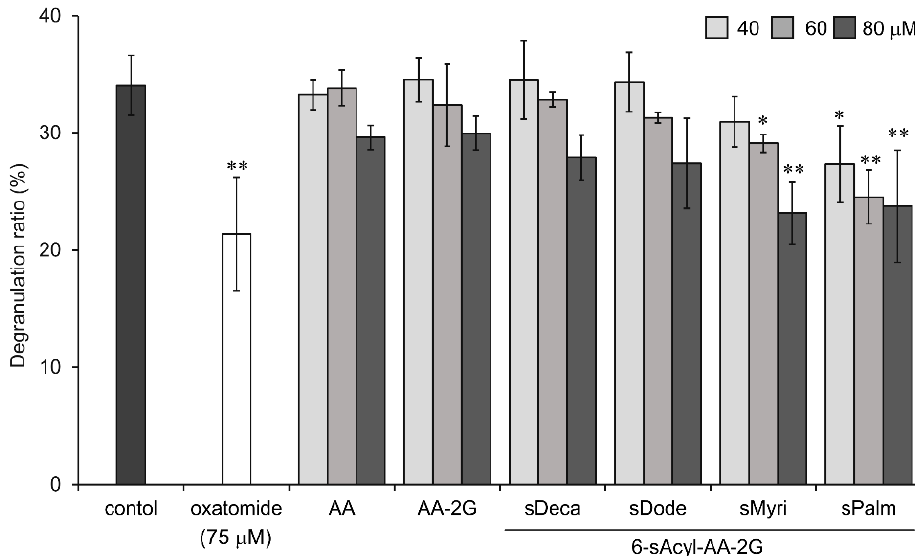
Figure 3. Inhibitory effects of 6-sAcyl-AA-2G on antigen-induced degranulation in RBL-2H3 cells. Anti-dinitrophenyl (DNP)-immunoglobulin E (IgE)-sensitized RBL-2H3 cells were incubated with the indicated samples and stimulated with DNP-human serum albumin (HSA). All data represent means ± SD of three independent cultures. * p < 0.05, ** p < 0.01 (Dunnett’s test) as compared with the control.